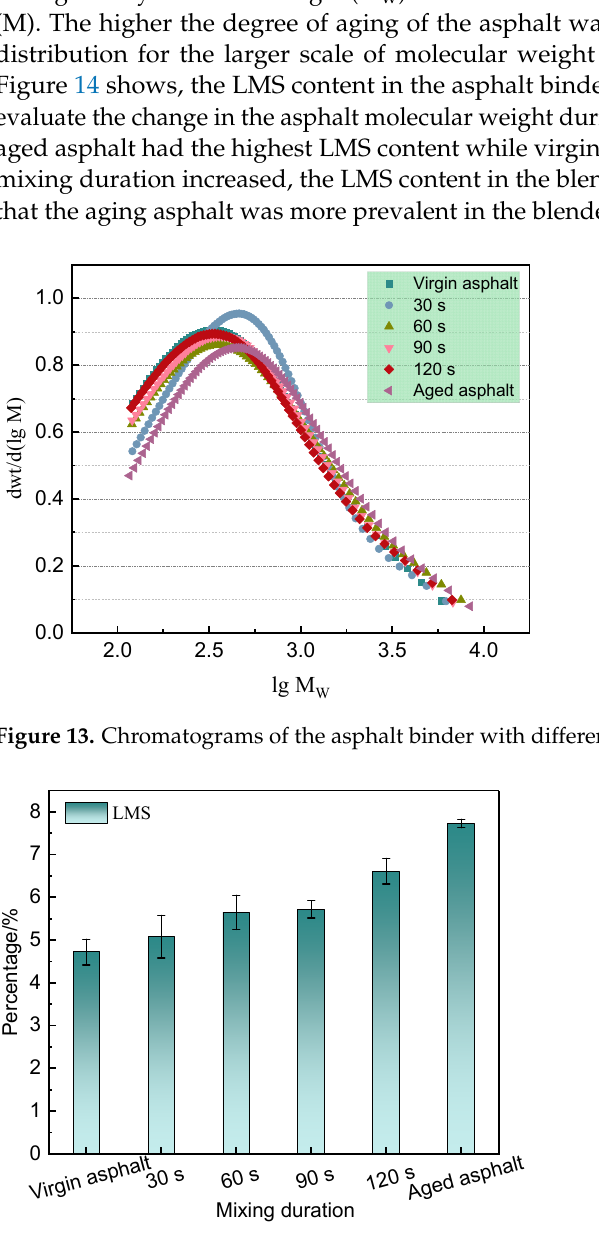
Figure 12. Variation in carbonyl index and sulfoxide index for the different asphalts.